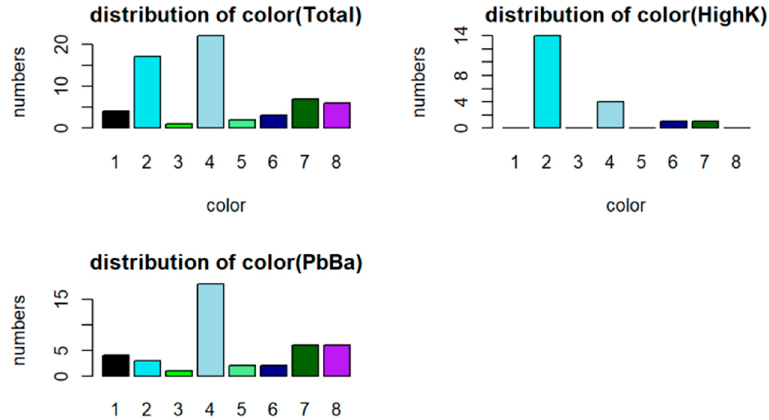
Figure 1. Samples color (type-based) data distribution.